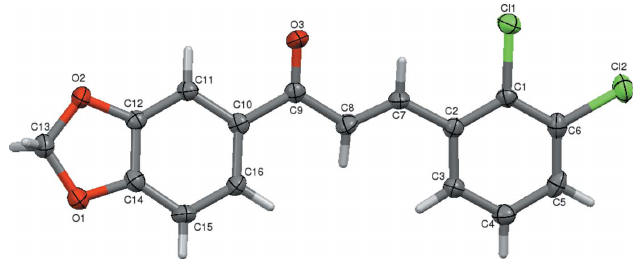
The molecular structure of the title compound with the atom-numbering scheme. Displacement ellipsoids for non-H atoms are drawn at the 50% probability